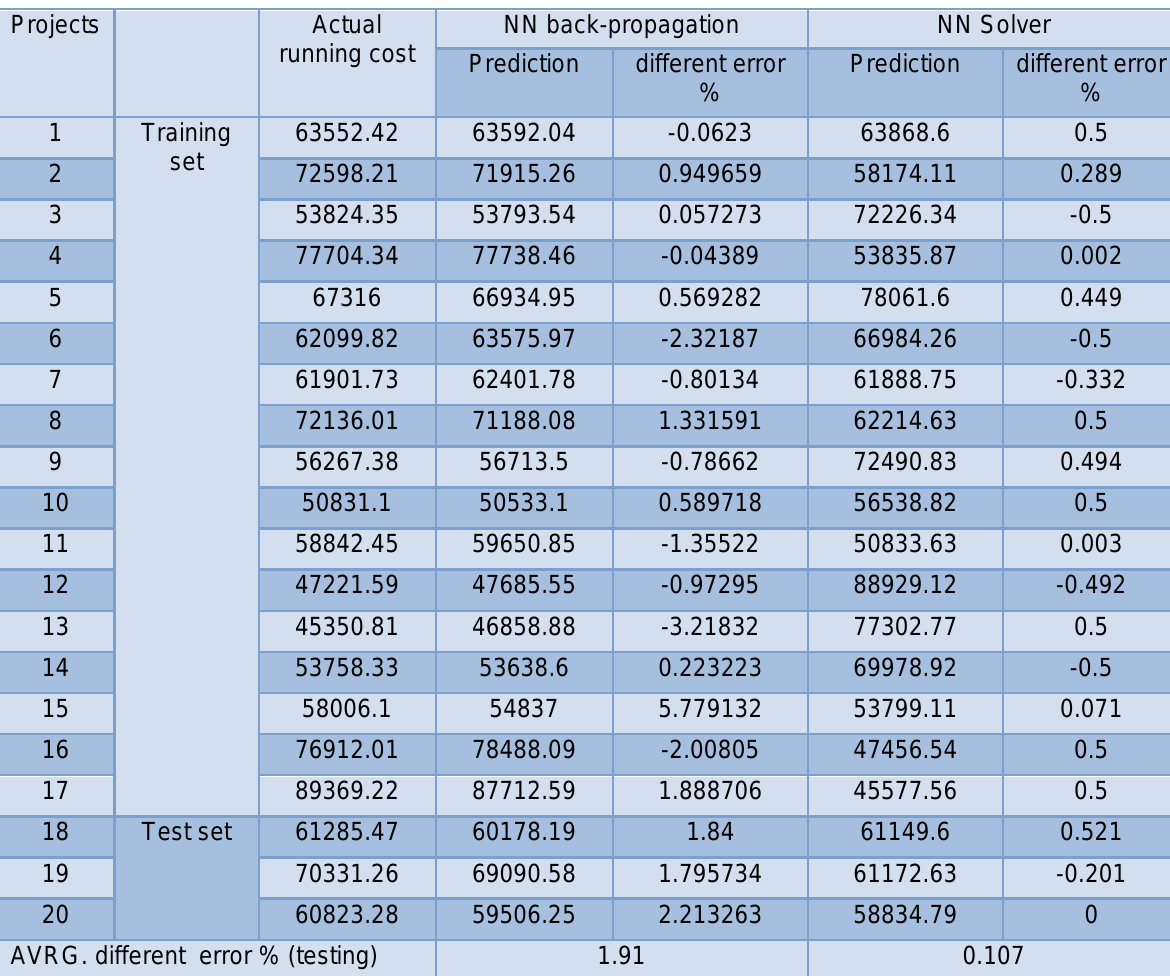
Table 4 Result of both neural network model for all 20 projects From table 4, the average difference between the actual value of running costs and the result from back-propagation neural network modelling for the testing projects was about